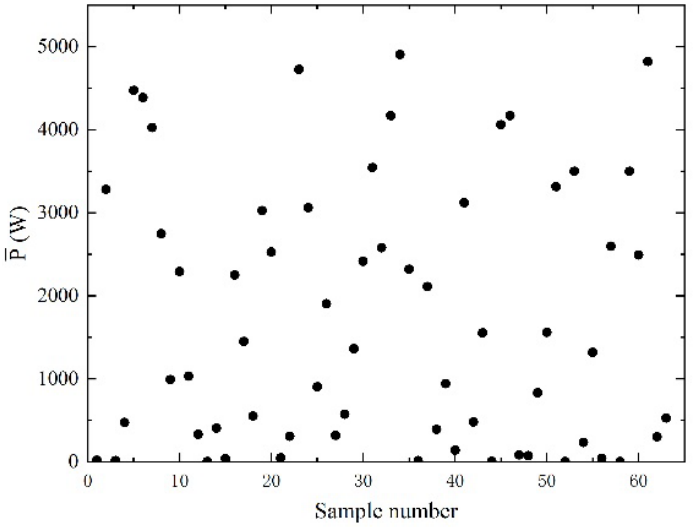
Figure 7. The mean annual power of each sample point. The sample library is divided into two groups, respectively named as the training set and the validation set. The first 52 groups of sample points are used as the training set, and the last 11 groups of sample points are used as the verification set. The prediction models are trained based on RSM, RBFNN and EBFNN, respectively. When the buoy radius is constant, the mapping relationship between the PTO system damping, draft-to-radius ratio and mean annual power is shown in Figure